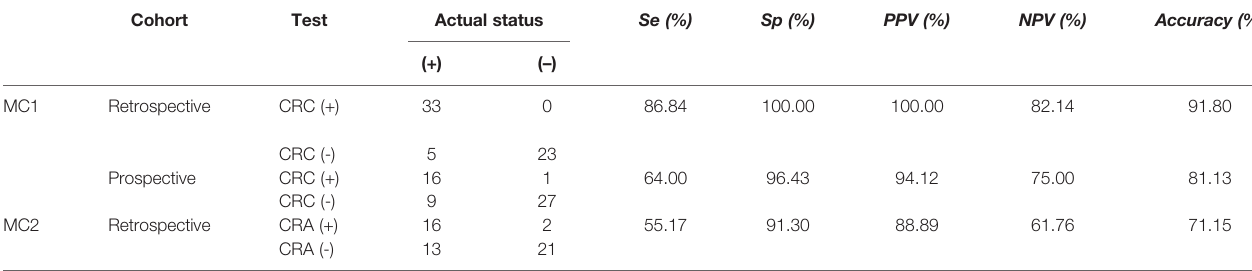
TABLE 3 | Diagnostic power of MC1 and MC2 in the retrospective validation and(or) prospective validation groups.